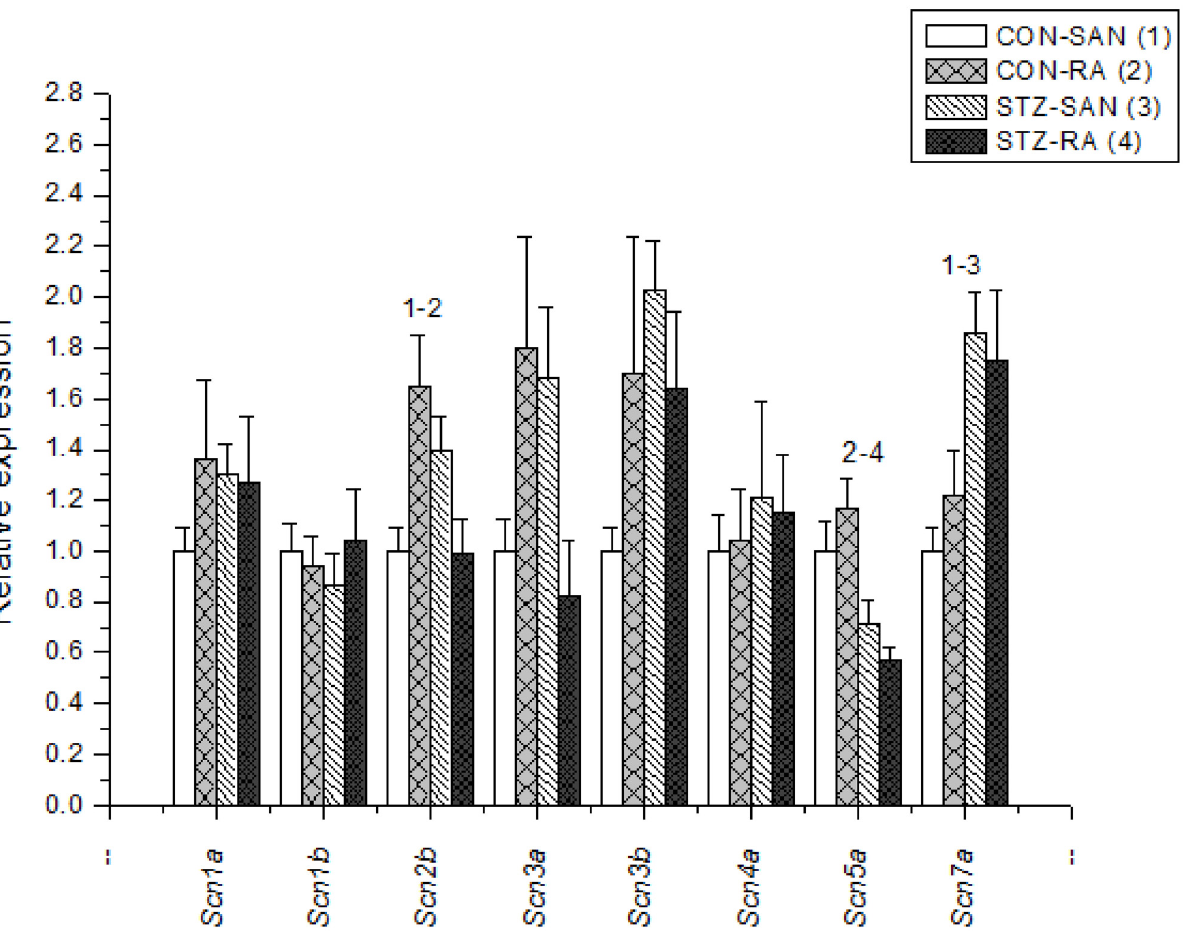
Fig 8. Expression of genes encoding various sodium channel proteins. Data are mean ± SEM, n = 8 – 10 samples from STZ and control rat each containing SANs from 2 hearts.